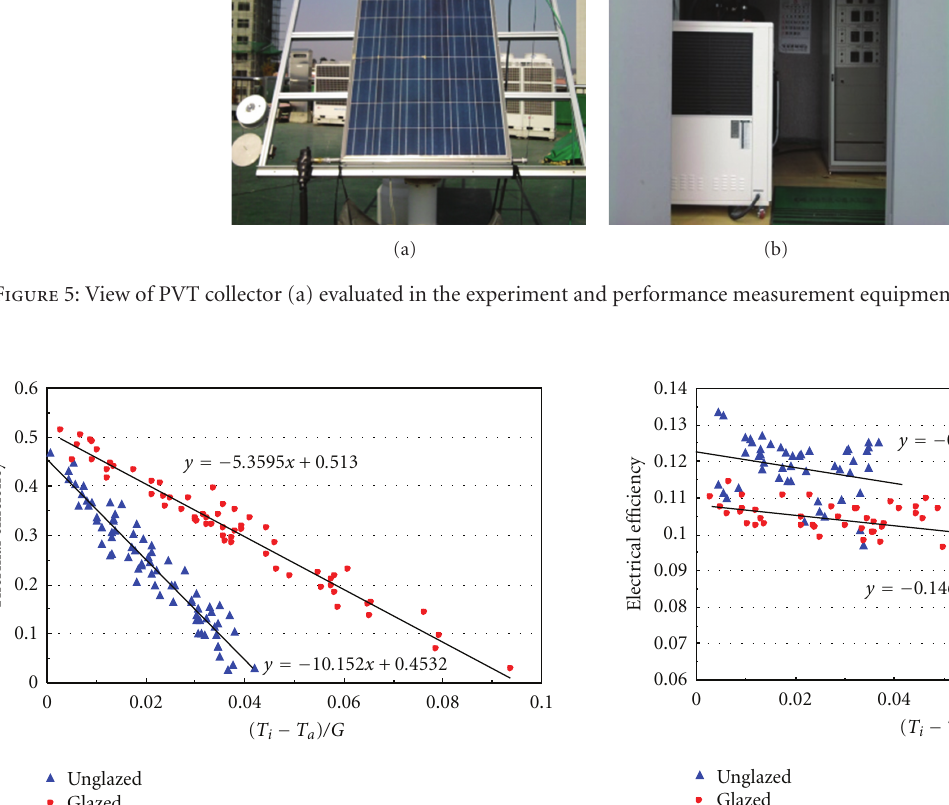
e ffi ciencies of the glazed and unglazed PVT collectors are about 10.3% and 11.8%,